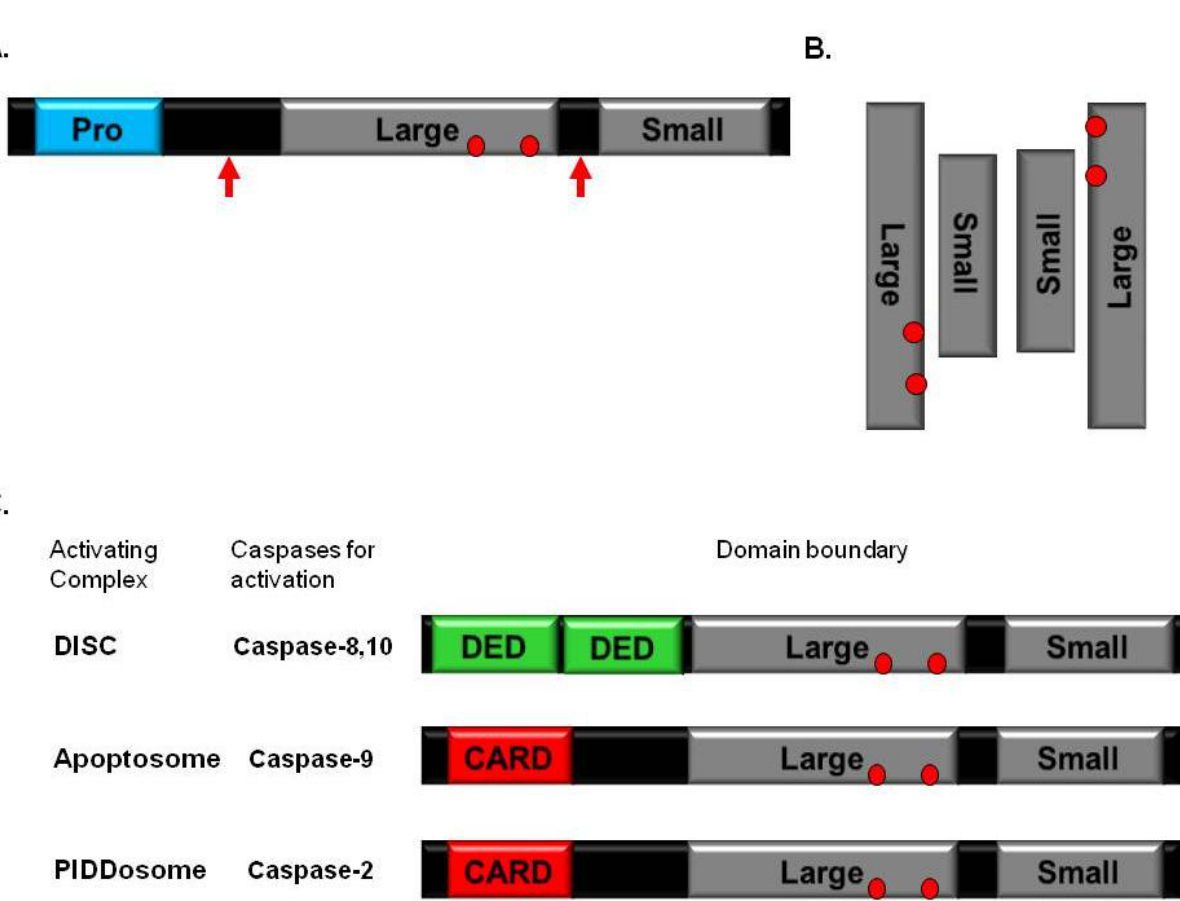
Figure 1. Initiator caspases and their activation. ( a ) Domain boundary of initiator caspase. Red arrows indicate proteolytic sites. Red circle indicates the catalytic sites; ( b ) Activated caspases. Red circles indicates the catalytic sites; ( c ) Domain boundary of initiator caspases and caspase-activating